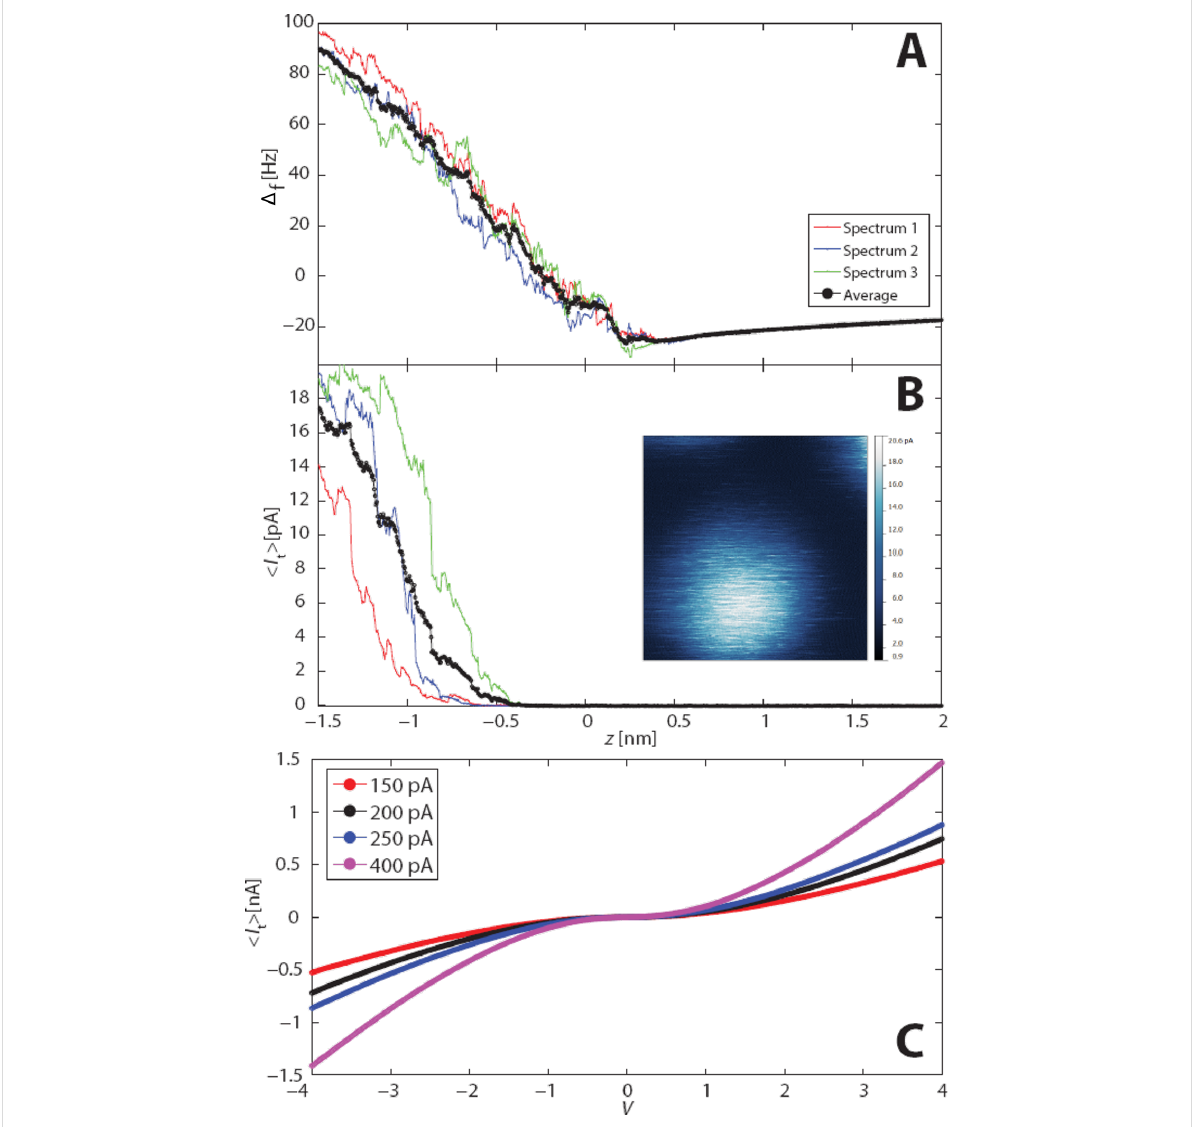
Figure 3: Simultaneous Δ f (A) and I t (B) data acquired over a single nanocrystal with an applied bias of V gap = +2 V. Note the absolute z positioning is identical to that used in Figure 2. Inset: Tunnel current map for an individual nanocrystal acquired immediately after the constant height DFM images shown in Figure 2. (C) I – V data acquired using a different tip apex at various feedback stabilisation currents (stabilisation bias +2 V